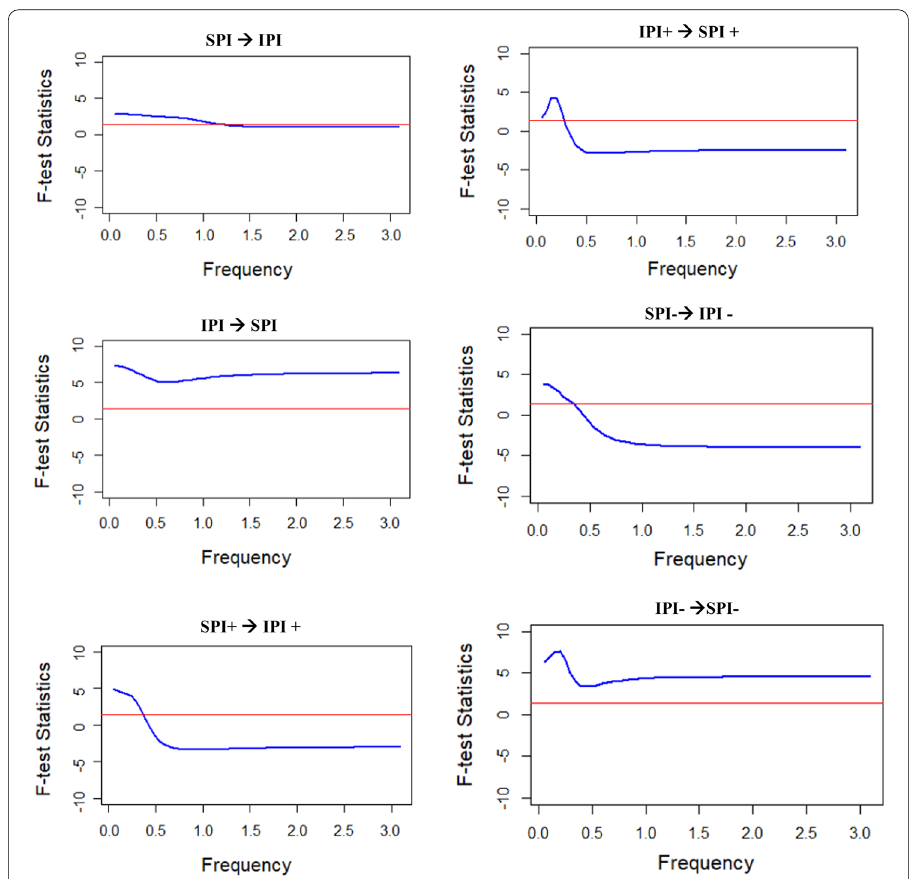
Fig. 3 The graphs of panel Granger causality test in the frequency